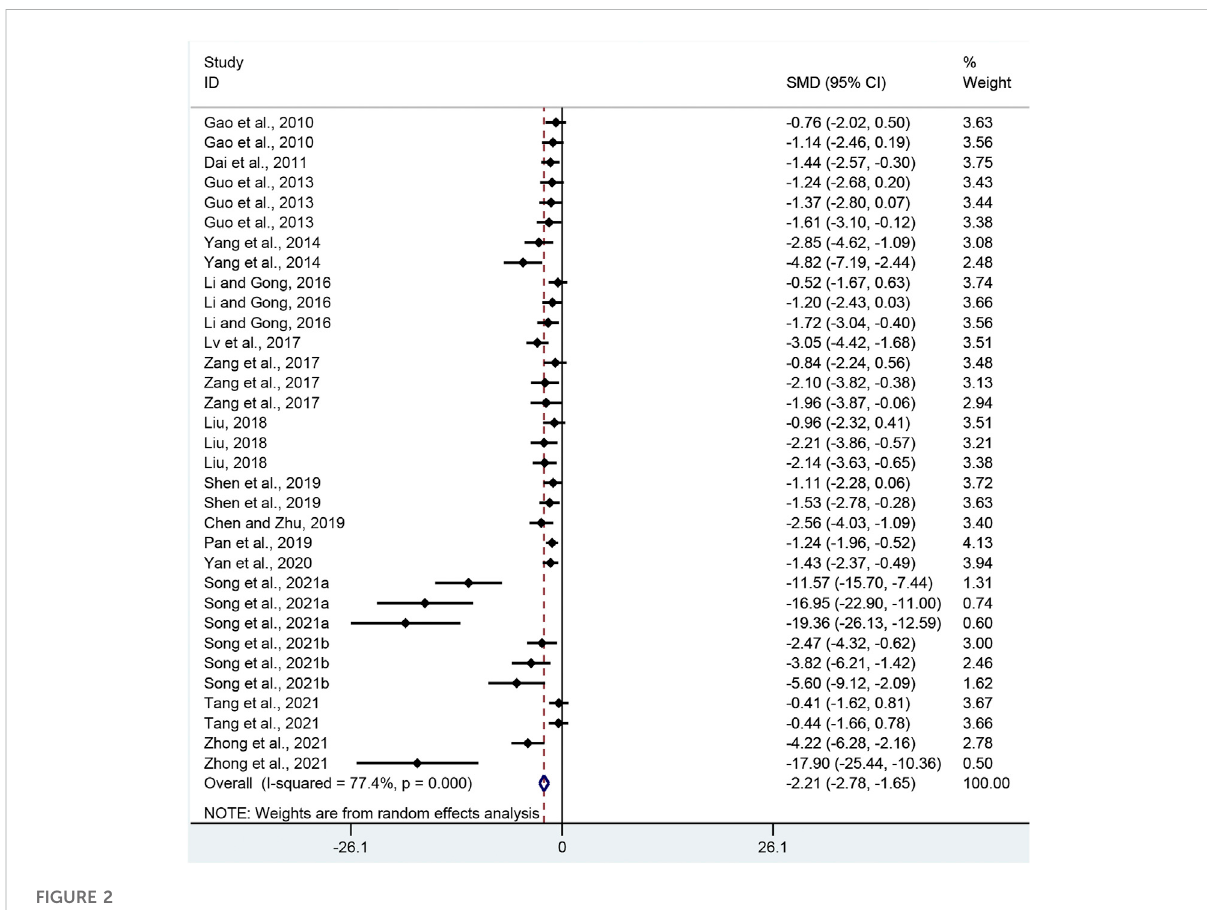
FIGURE 2 Pooled estimate of DAI with